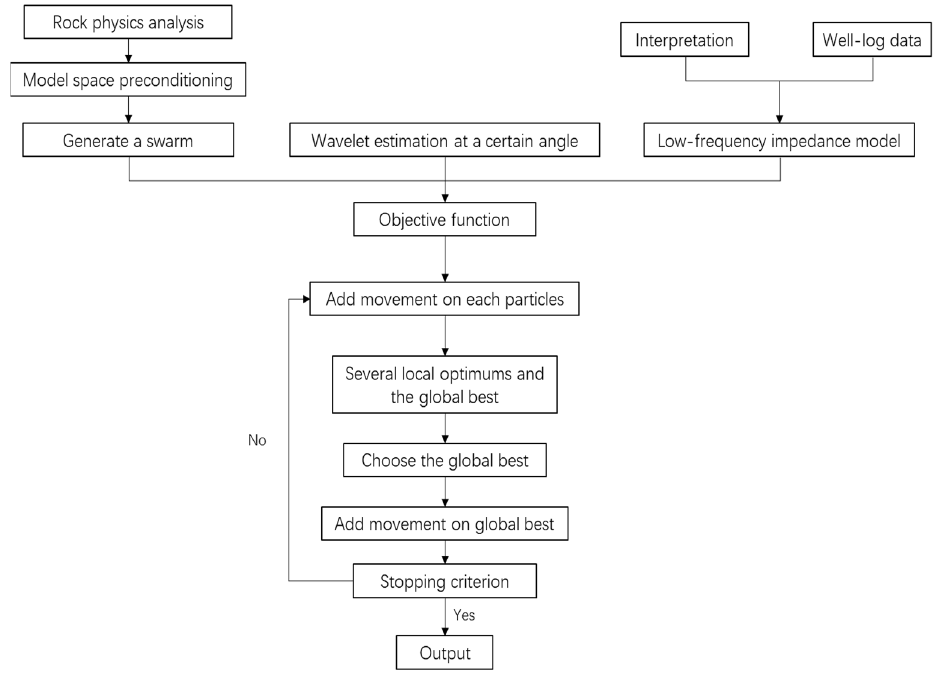
Figure 2. The general workflow of stochastic inversion.